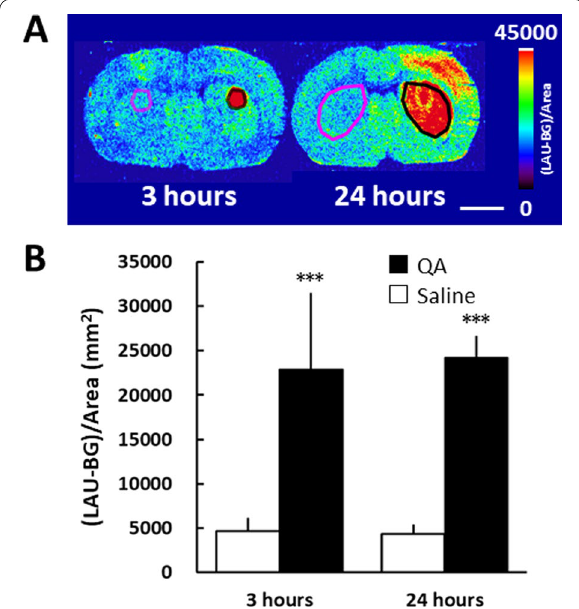
Fig. 2 DHE uptake at 3 h and 24 h after QA injection. QA was injected into the striatum on the right side of the image, and saline was simultaneously injected into the contralateral striatum. A Accumulation of fluorescence in the QA-injected striatum 60 min after the intravenous injection of DHE. B Semiquantitative analysis of the fluorescent images. The regions of interest (ROIs) were identified based on the strong fluorescence signal region of the striatum and the corresponding region on the opposite side. Mean SD, n 4–9. ± = *** P < 0.001, between the saline- and the QA-injected side using the Student’s paired t-test. Bar 5 mm =